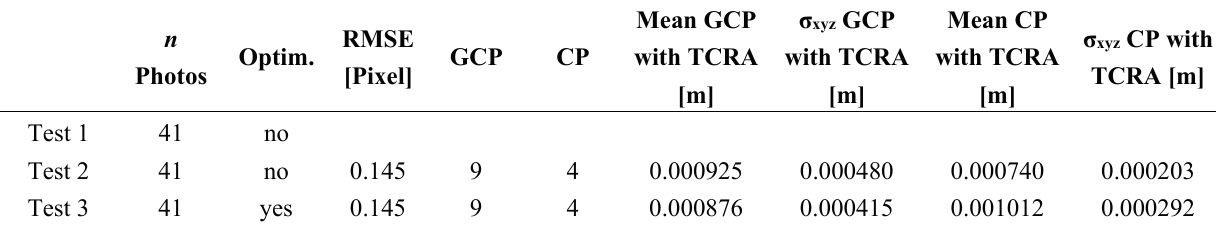
Table 1. Comparison of dataset